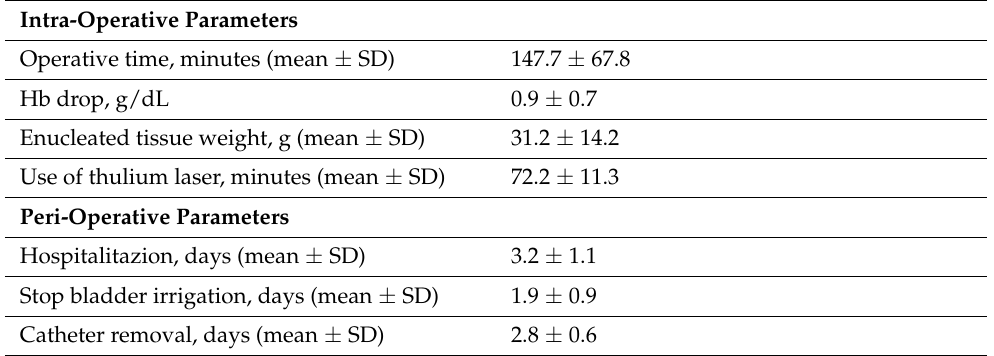
Table 2. Intra- and peri-operative parameters.